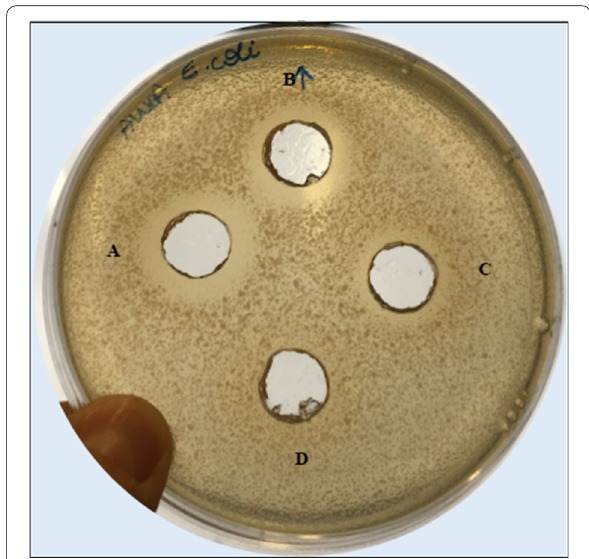
Fig. 1 Antimicrobial activity of Lactobacillus plantarum PBS067 cell free supernatant. The antimicrobial activity of L. plantarum PBS607 cell free supernatant (CFS) was determined as halo of growth inhibition of E. coli ATCC 25922 through the agar well diffusion assay. The figure shows the inhibition zones produced by CFS (A), by neutralized-acidified CFS (B), not inoculated MRS at pH 4 (C), not inoculated MRS (D) against E. coli ATCC 25922